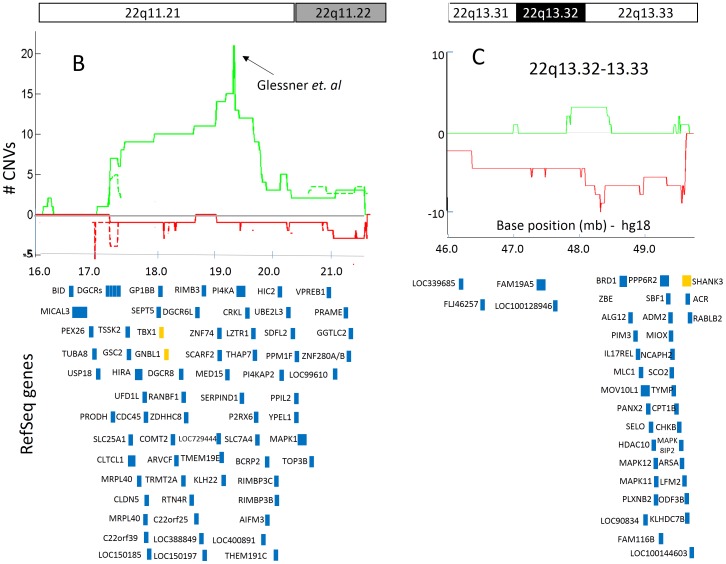
ASD susceptibility CNV loci on human chromosome 22.The number of individuals with duplications (green) and deletions (red) are plotted for both ASD cases (continuous lines) and controls (broken lines, on a log2 scale) along human chromosome 22q11.21-13.33. RefSeq genes overlapping with these regions are depicted in blue rectangles. Genes that have been associated with ASD according to AutDB [18] are colored in orange. (A) The CNV locus on 22q11.21 contains primarily copy number gains (duplications). A black arrow indicates the peak in duplications count due to the CNV data from Glessner et. al. (B) The CNV locus on 22q13.32-13.33 contains primarily copy number losses (deletions).